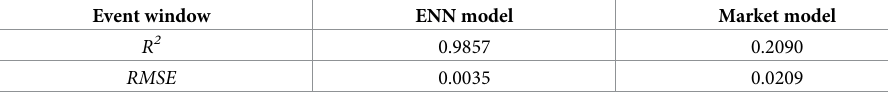
Table 4. Average testing R 2 and RMSE for the two models.